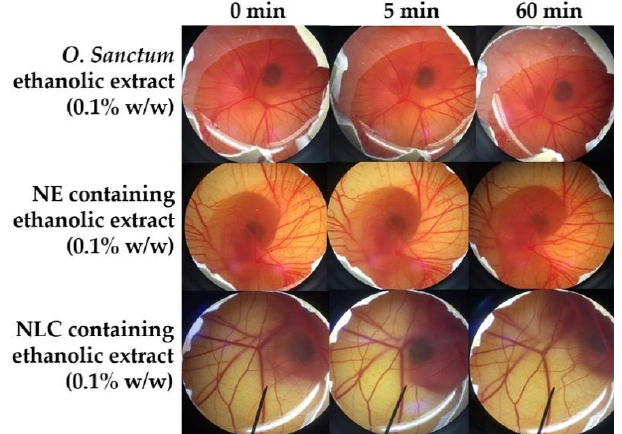
Figure 9. Photographs illustrating the effect of 0.1% w/w O. sanctum ethanolic extract, nanoemulsion (NE) containing 0.1% w/w O. sanctum ethanolic extract and nanostructured lipid carriers (NLC) containing 0.1% w/w O. sanctum ethanolic extract on chorioallantoic membrane before exposure the sample (0 min), after 5 min, and at the end of the experiment of 60 min.